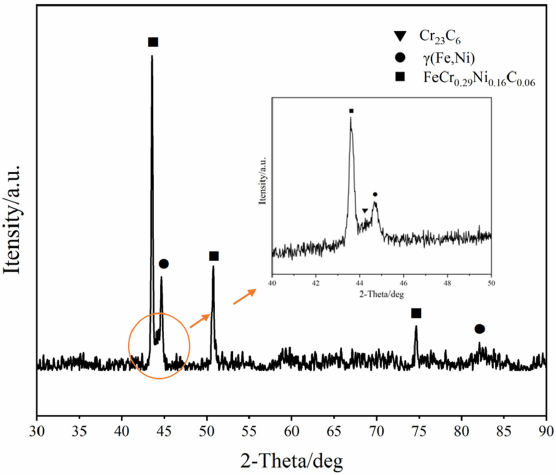
Figure 4. X-ray diffraction pattern of the alloyed layer.